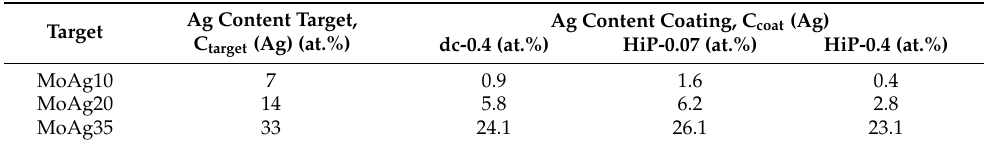
Table 2. Silver content of the MoAg compound targets and of the deposited MoN-Ag coatings of the 3 series without substrate bias (measured by WDX, 7